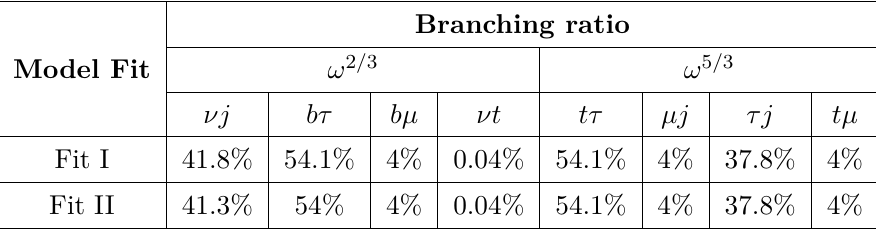
Table 3 . Branching ratios for different decay modes of the R 2 LQ corresponding to the fits presented in eqs. (7.3) and